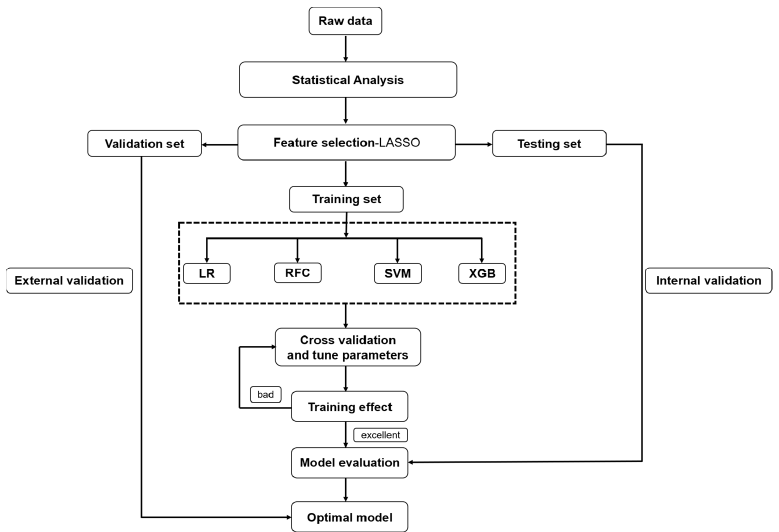
Figure 1. Modeling procedure. Machine learning involved feature selection by LASSO, model building with five algorithms. LASSO, Least Absolute Selection and Shrinkage Operator; LR, Logistic Regression; RF, Random Forest; SVM, Support Vector Machine; XGBoost, Extreme Gradient Boosting.